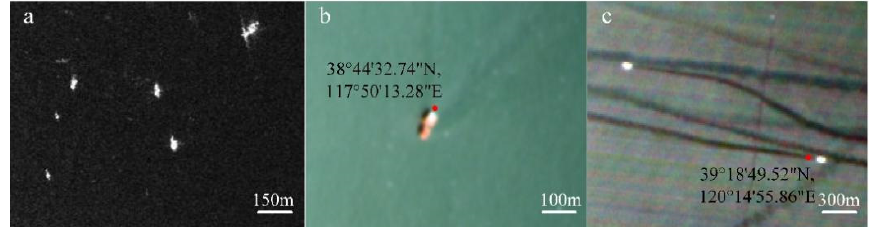
Figure 1. ( a ) The SAR image with the resolution of 15 m in SSDD dataset [31], The ( b ) true color image of 460–520 nm, 520–600 nm and 630–690 nm with resolution of 10 m in 38°44 ′ 32.74 ″ N,117°50 ′ 13.28 ″ E from SDGSAT-1 multispectral imager, and ( c ) pseudo-color image of 8~10.5 µm, 10.3~11.3 µm, 11.5~12.5 µm with resolution of 30 m in 39°18 ′ 49.52 ″ N,120°14 ′ 55.86 ″ E Table 1. The summary of ship